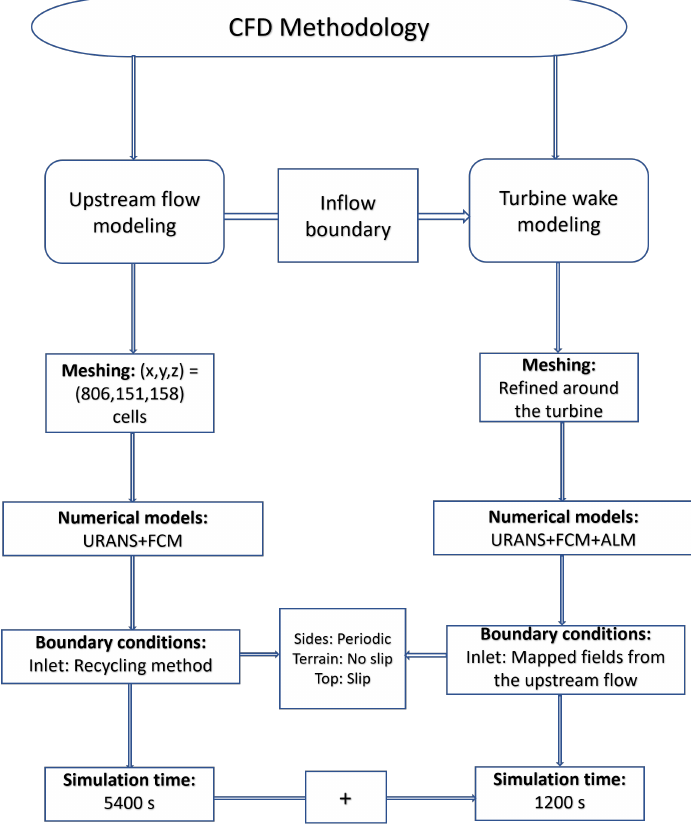
Figure 8. CFD methodology flowchart.